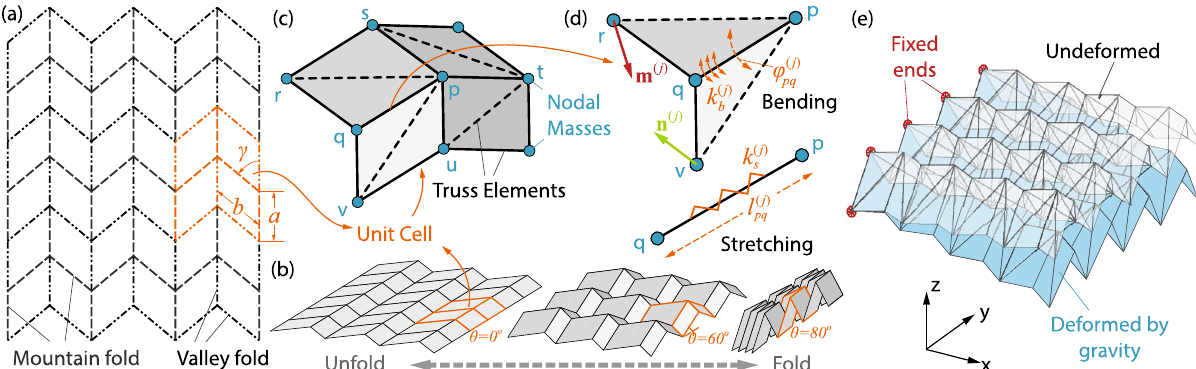
Figure 1. The nonlinear Truss-frame approach for simulating the origami dynamics. ( a ) The crease pattern of the classical Miura-ori, with a unit cell highlighted. ( b ) The rigid-folding kinematics of the Miura-ori. ( c